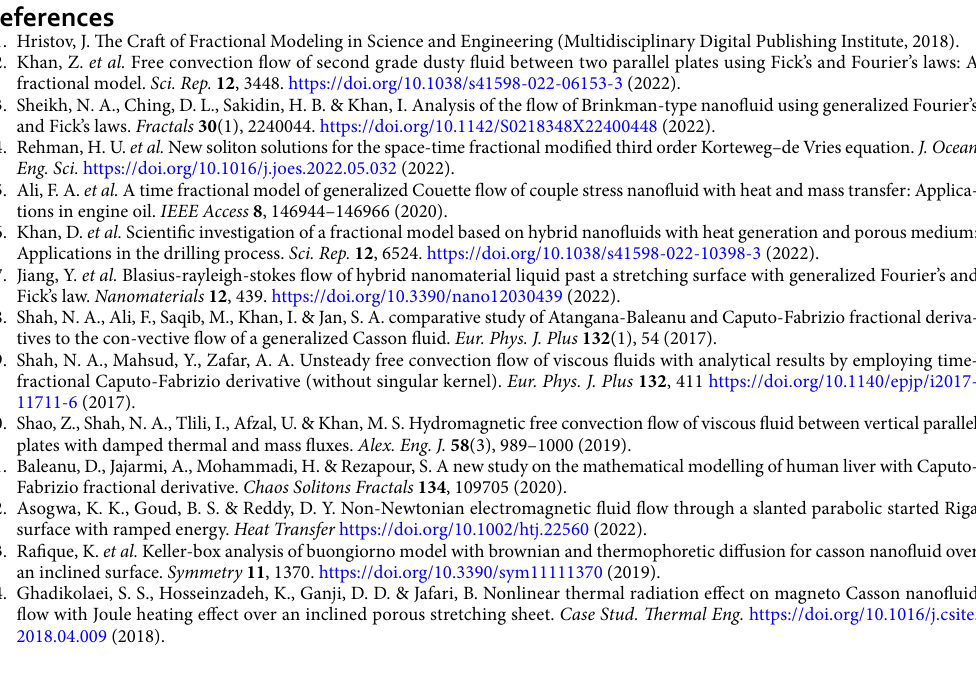
Figure 24. The consequence of φ on the Bejan number. Where R ζ Gr = 10, Gm = 20, β = 0.2, α = 0.5, t = 1, Sc = 10, B r = 0.5, � =